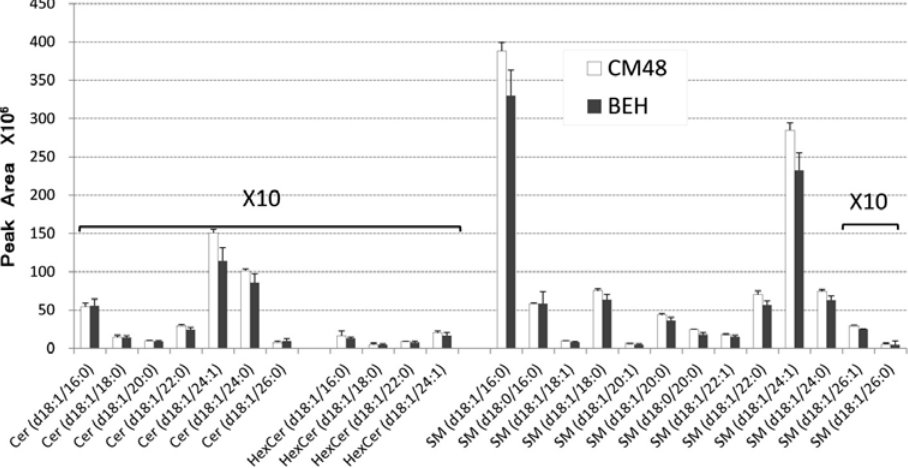
Figure 2. Comparison of the recovery of sphingolipids extracted by the chloroform/methanol at 48 °C (CM48) and butanol/ethyl acetate/hexane (BEH) methods. Lipids from 1 × 10 6 WR19/Fas-SMS1 (WR/SMS1) [24] cells were extracted using either the CM48 or BEH method (see text). Both extracts were analyzed by LC-MS/MS. Values are expressed as the mean ± SD ( n = 3).